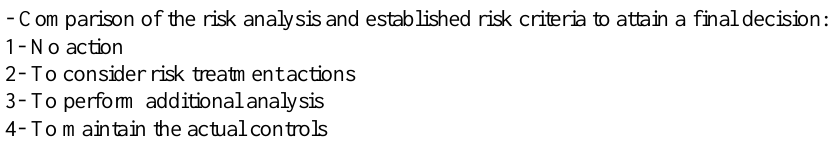
Figure 4. Three steps of the risk assessment process (Source: ISO/TS 13131:2014).